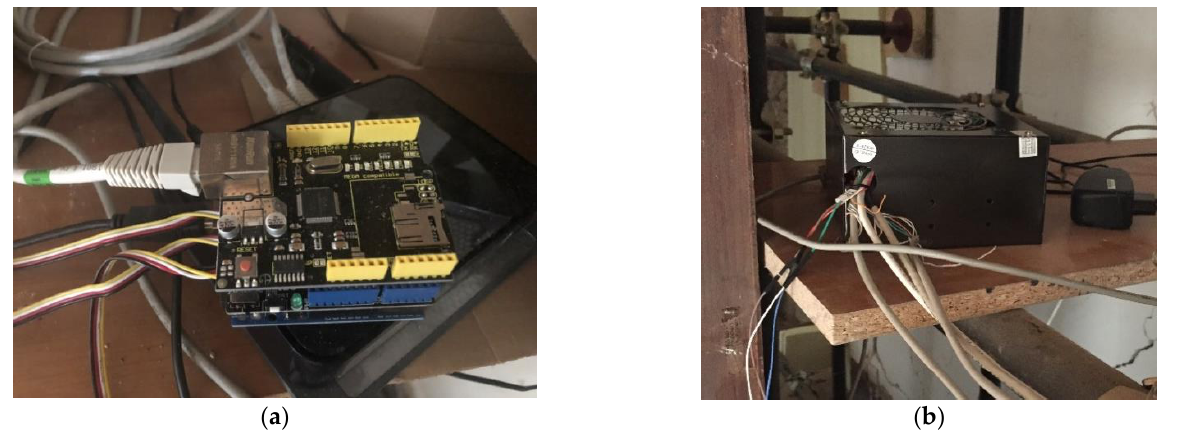
Figure 5. Base station (Arduino system). ( a ) Arduino System assembled ( b ) Arduino System with the cover.